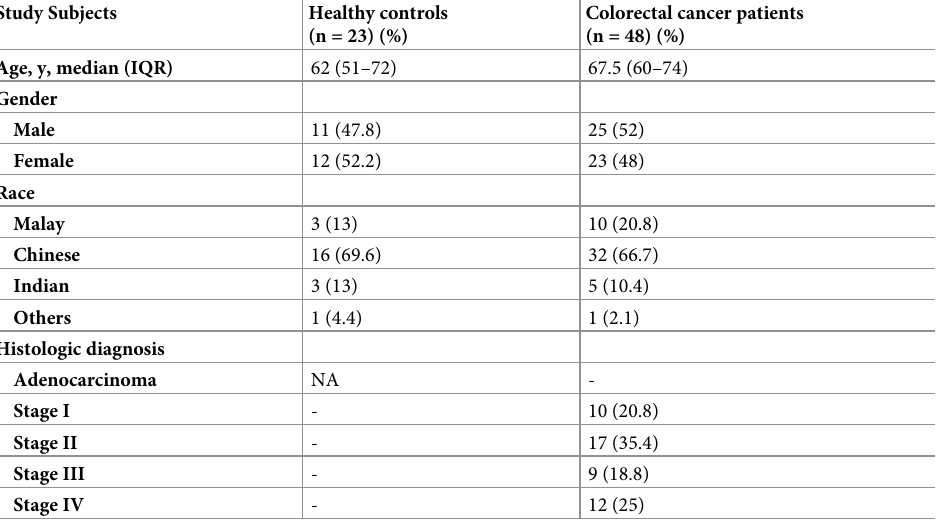
Table 1. Characteristics of the study